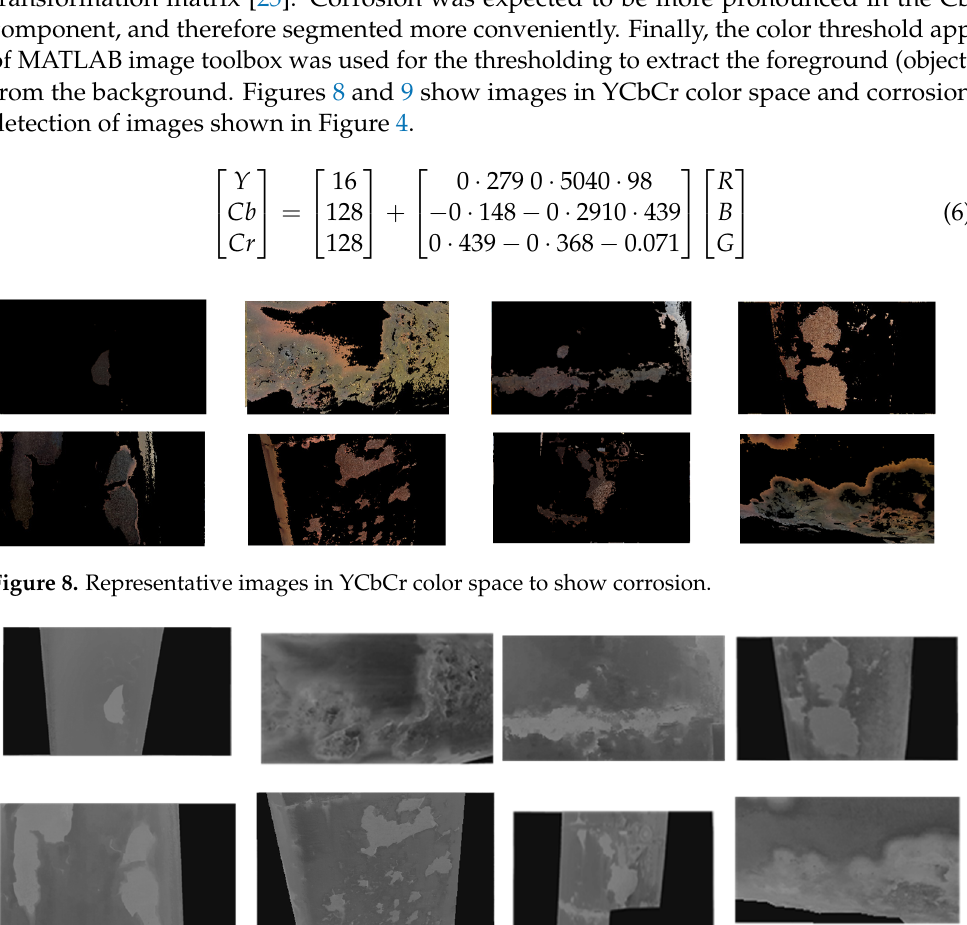
Figure 7. ( a ) Original image; ( b ) selected regions as background; ( c ) binary mask of background; ( d ) overlaid image.